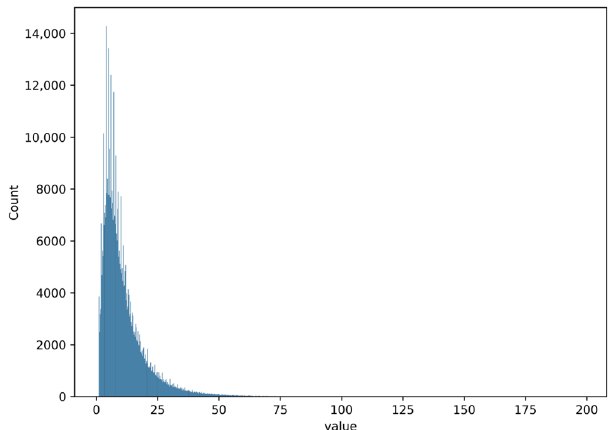
Figure 2. The distribution of the measured PM 2.5 used in this study.